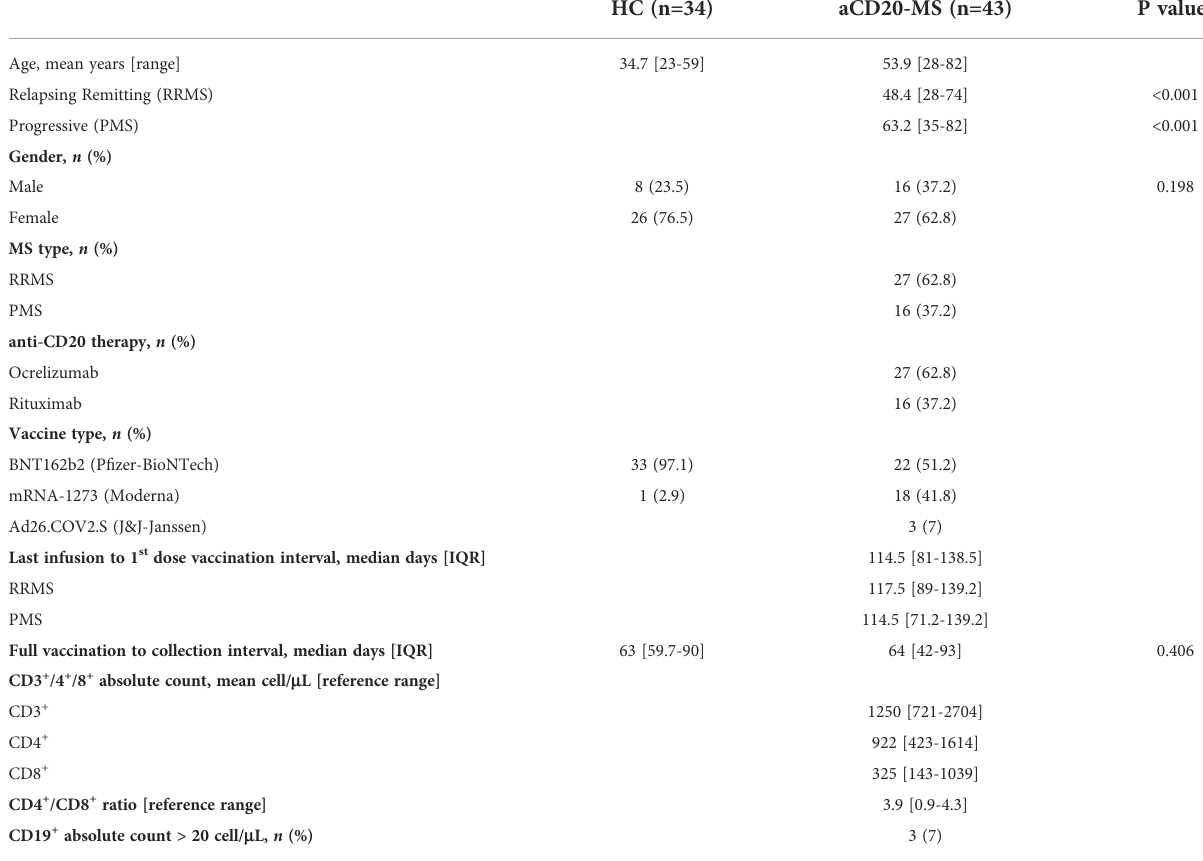
TABLE 1 Clinical characteristics of study